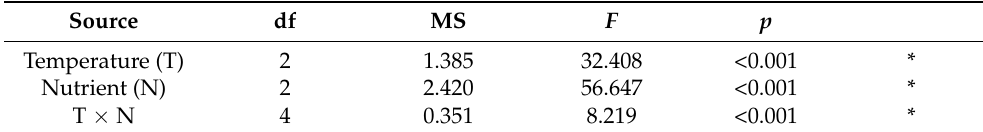
Table 1. Results of two-way ANOVA on the effects of temperature and nutrient availability on the relative growth rate of Sargassum fusiforme germlings.